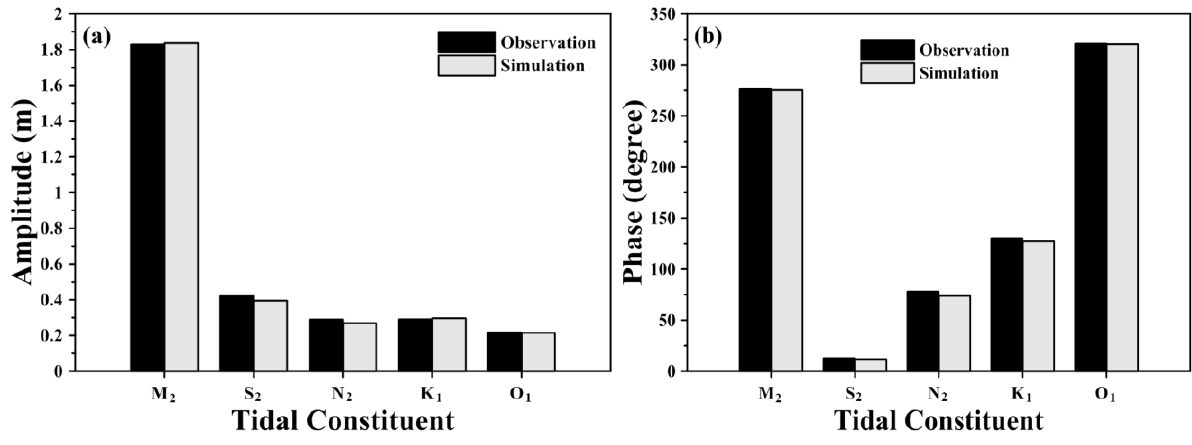
Figure 5. Comparisons of amplitude and phase of five major tidal harmonics computed with a three-dimensional model and obtained from tide measurements ( a ) amplitude; ( b )